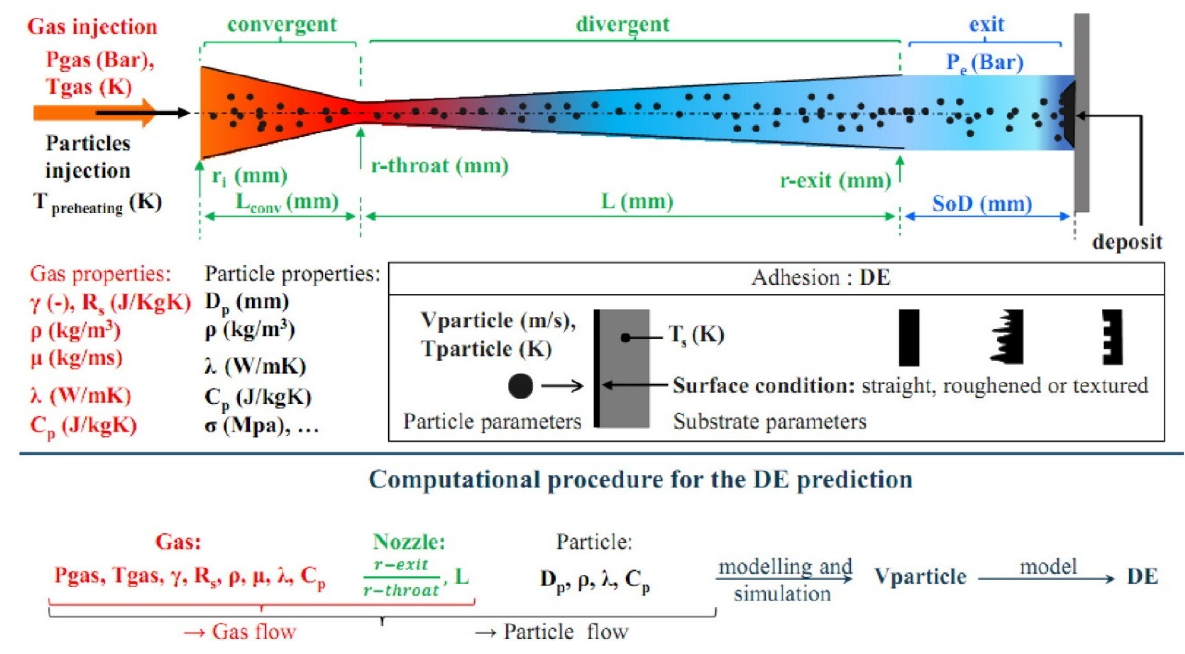
Figure 1. Major CS process parameters and computational procedure of the DE. Reprinted with permission from [69]. Copyright 2016 Elsevier.